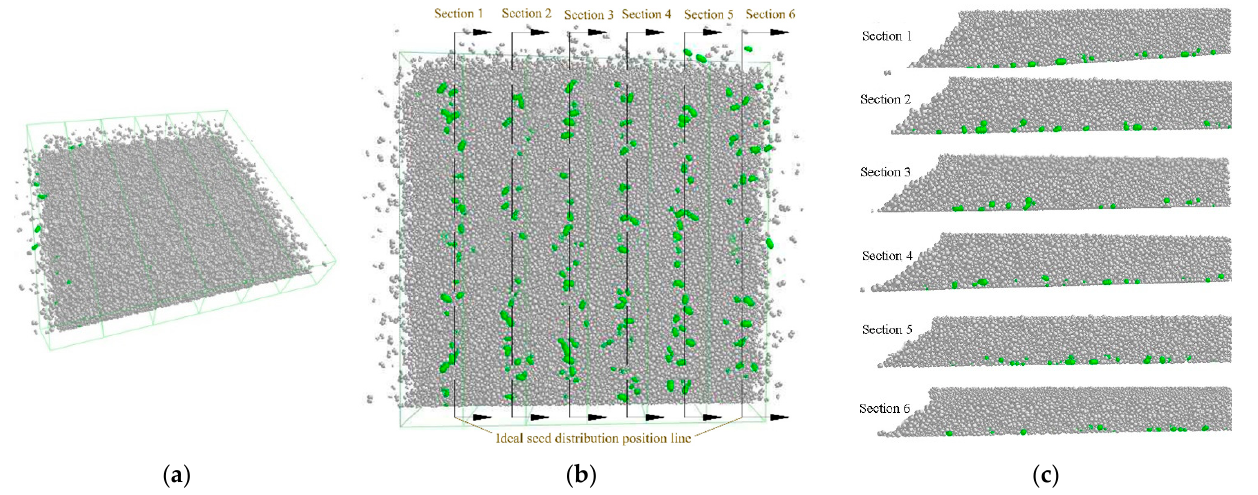
Figure 9. Effect analysis of throwing soil and covering seeds. ( a ) Top view when t = 0.1 s; ( b ) bottom view when t = 0.1 s; ( c ) t6 sectional views when t = 0.1 s.